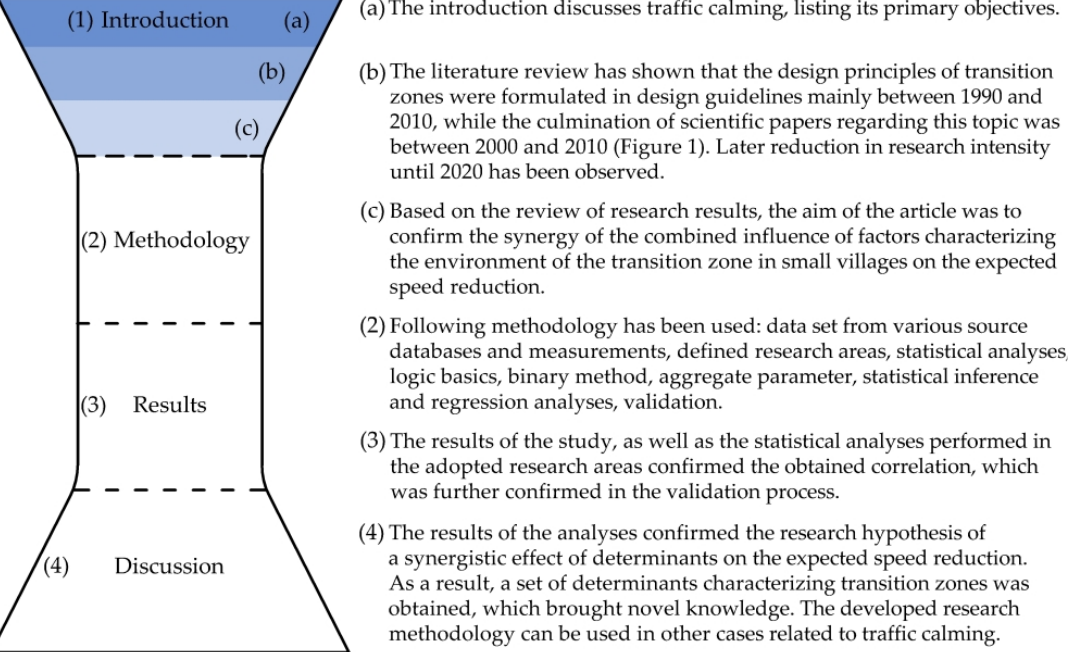
Figure 3. IMRAD structure of the article.